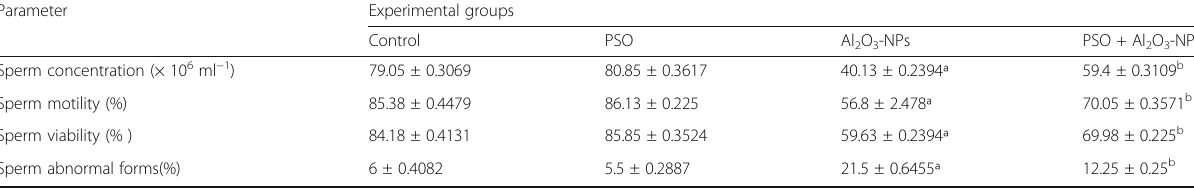
Table 1 Effect of pumpkin seed oil on the percentage of sperm parameters in rat administrated with Al 2 O 3 -NPs Parameter